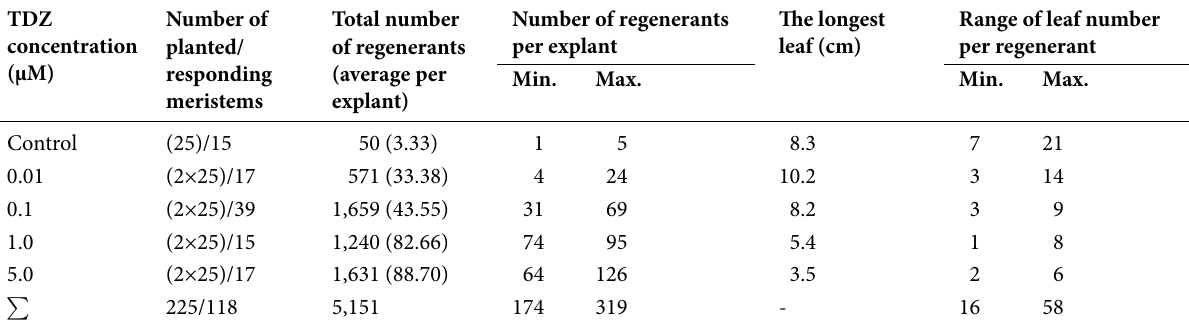
Table 1 e regeneration potential described by the number of regenerants, and the level of their potential expressed by the range of the number of leaves achieved in two steps of culture; first: long-term experiments with the shoot apical dome initially cultured on medium supplemented with various concentration of thidiazuron [TDZ; 1-phenyl-3-(1,2,3-thiadiazol-5-yl)-urea)] + naphthalene acetic acid (NAA) and second: subculture on 1/2 Murashige and Skoog hormone-free